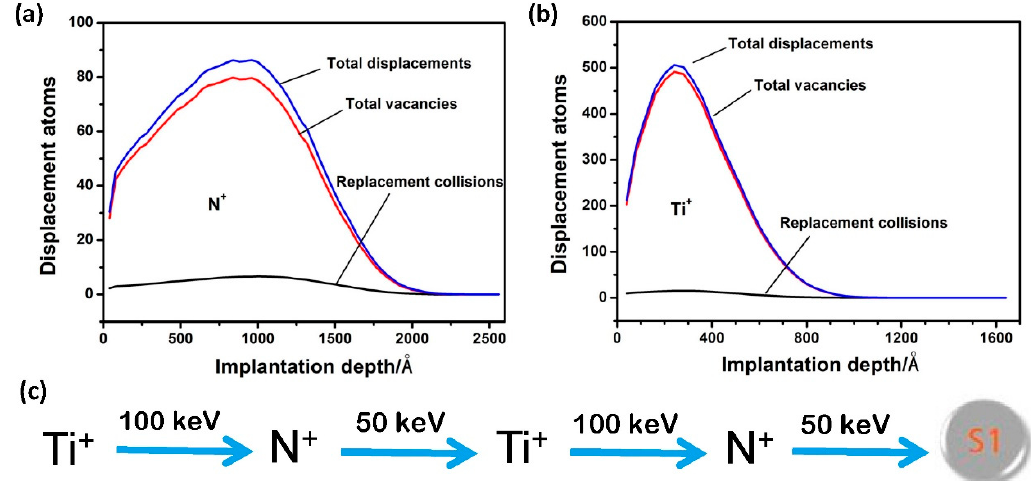
Figure 1. Ion implantation processes: ( a , b ) Transport of Ions in Matter ( TRIM ） simulation results showing the N + and Ti + implantation-induced distribution of displacement atoms at fluence of 1.0×10 17 ions/cm 2 as a function of implantation depth, respectively, and ( c ) processing parameters of dual Ti + N implanted sample S1.